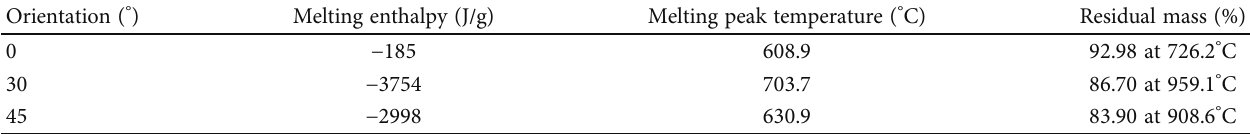
Table 3: Thermal endurance at di ff erent orientations of basalt fi ber – reinforced anamide